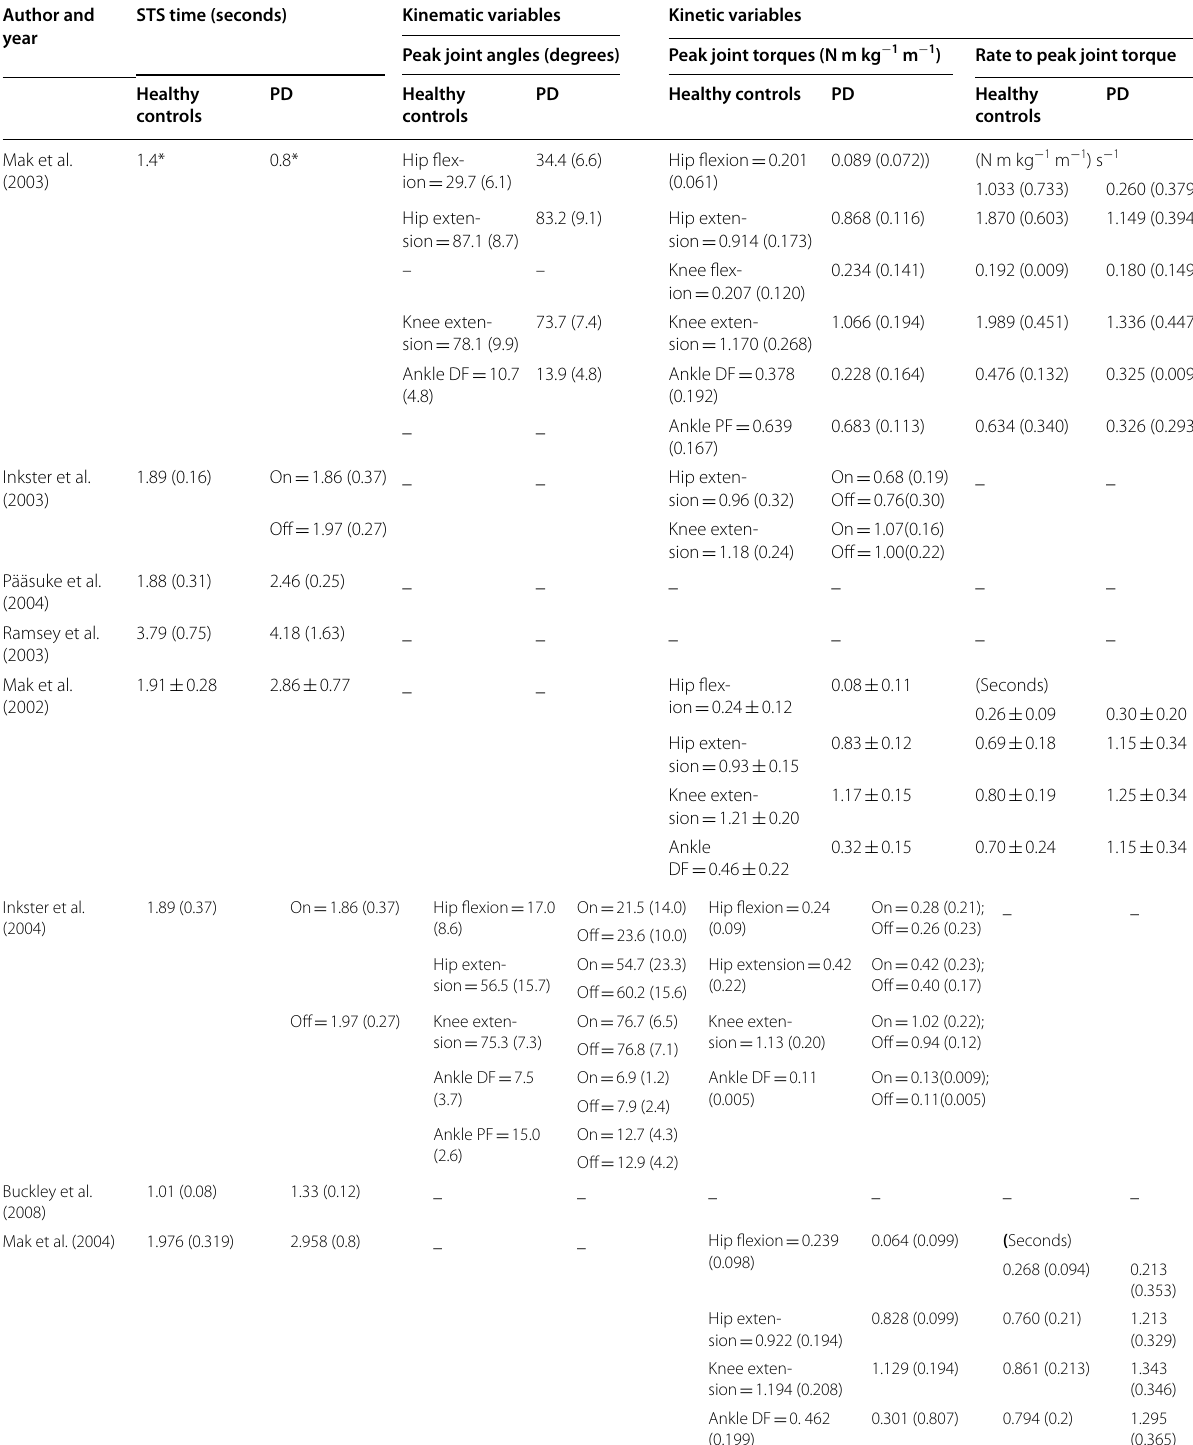
Table 4 Kinetic, kinematic and temporal determinants of sit-to-stand in Parkinson’s disease